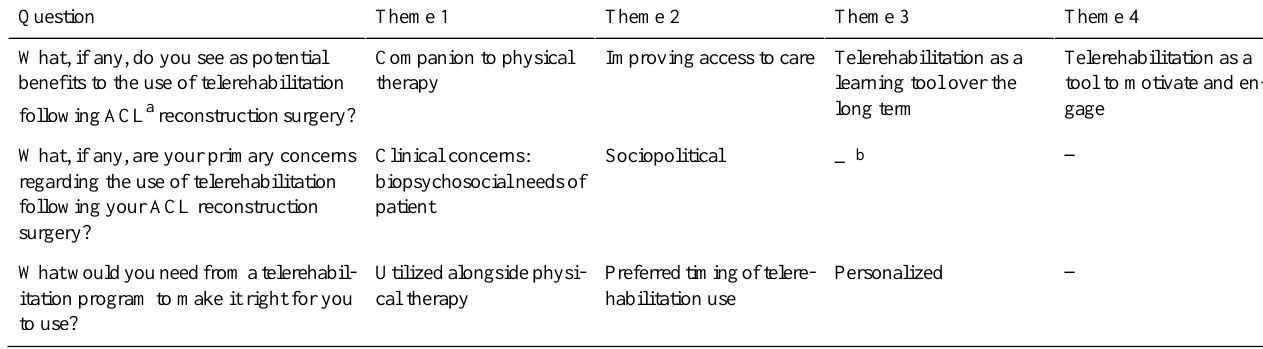
Table 4. Experience and opinions of telerehabilitation: qualitative